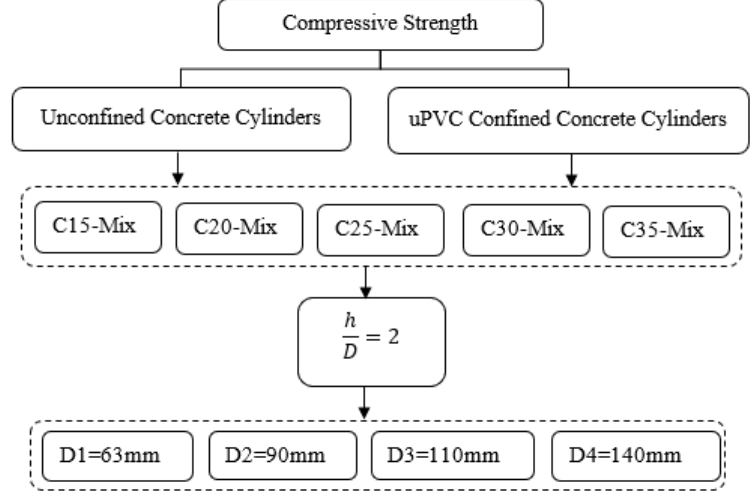
Figure 5. Matrix of variables considered for preparation of unconfined and uPVC confined concrete equivalent cylinders. Buildings 2019 , 9 , x FOR PEER REVIEW